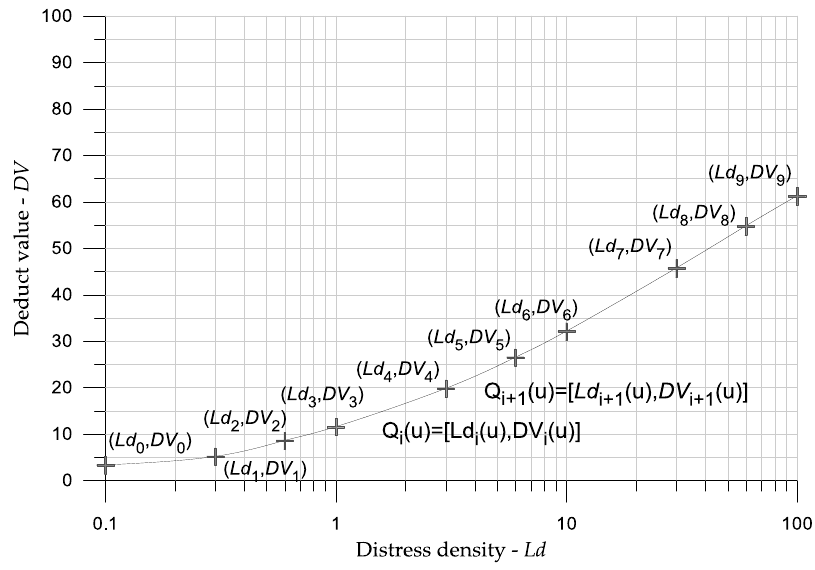
Figure 5. Logarithm Density—Deduct value Polynomial Interpolating Curve Hermite procedure. For each segment Q i ( u ) ( Ld i ( u ), DV i ( u )), between each pair of known data points, the parametric